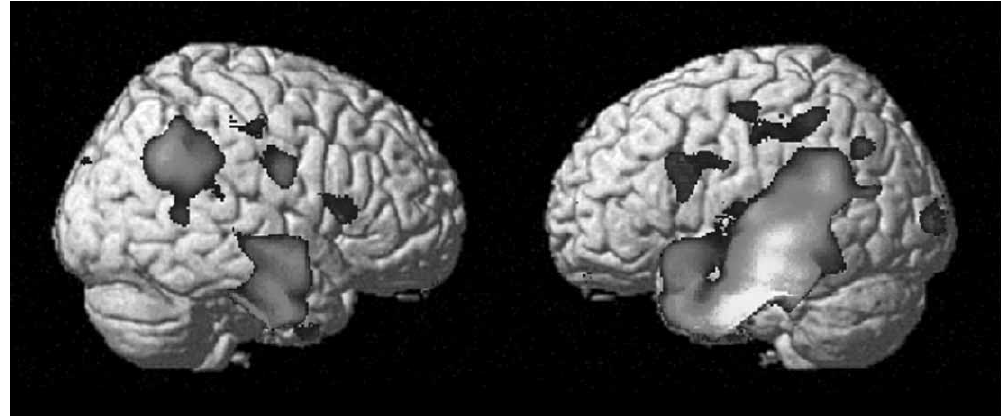
Fig. 1. Patients versus control. Involvement of a large network centered in the perysilvian region and left temporal